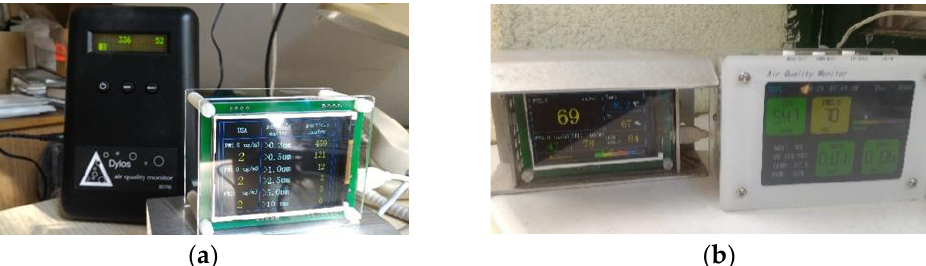
Figure 1. Pictures of the Dylos air quality monitor and a GPM sensor without housing at the background site ( a ) and a GPM sensor with aluminum housing next to a BH1 unit at the urban site ( b ). For air quality monitoring, PM 1 , PM 2.5 , and PM 10 were sampled with a resolution of